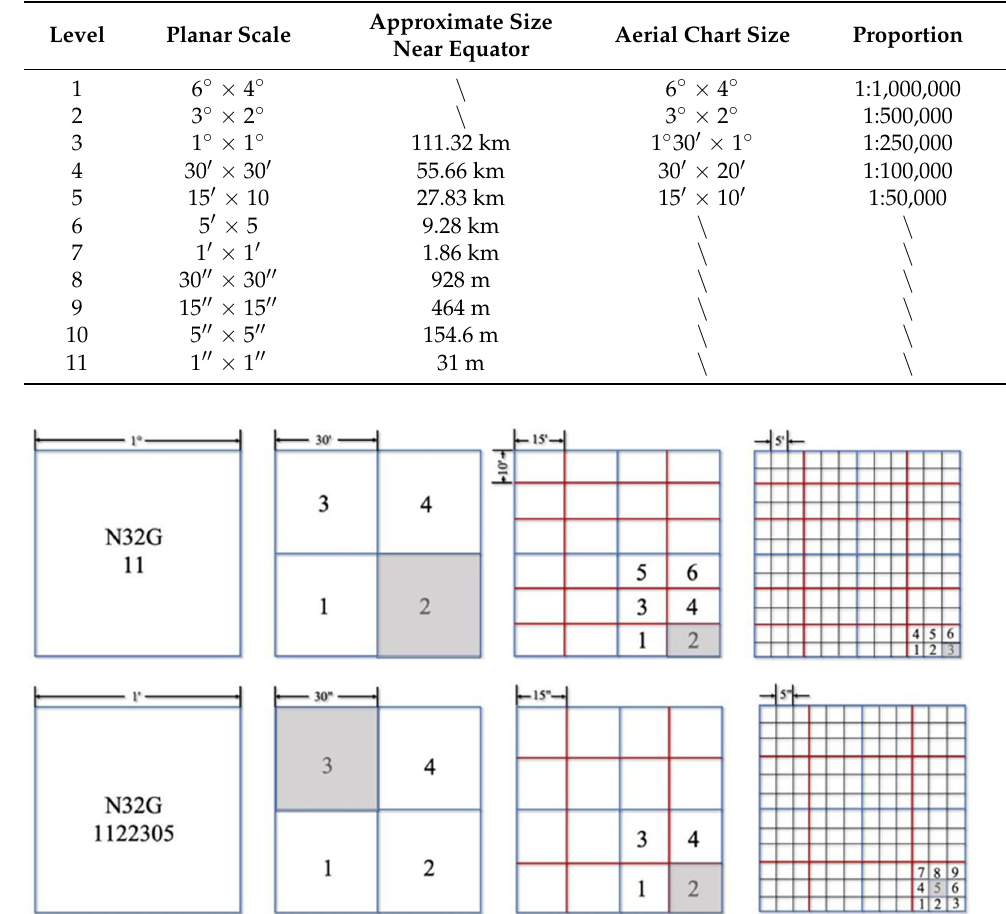
Table 1. GeoSOT-AS planar dimensional dissection scales corresponding to multi-level charts. Level